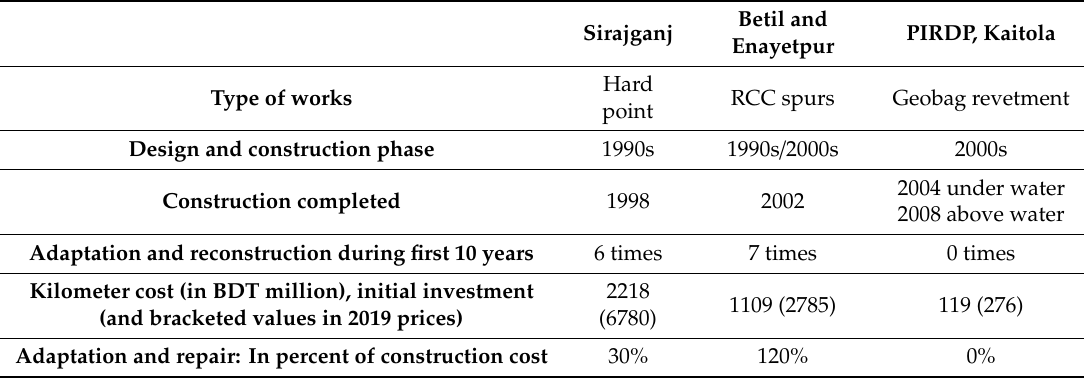
Table 3. Comparison of cost for Sirajganj “hard point”, Betil and Enayetpur RCC spurs, and Kaitola geobag